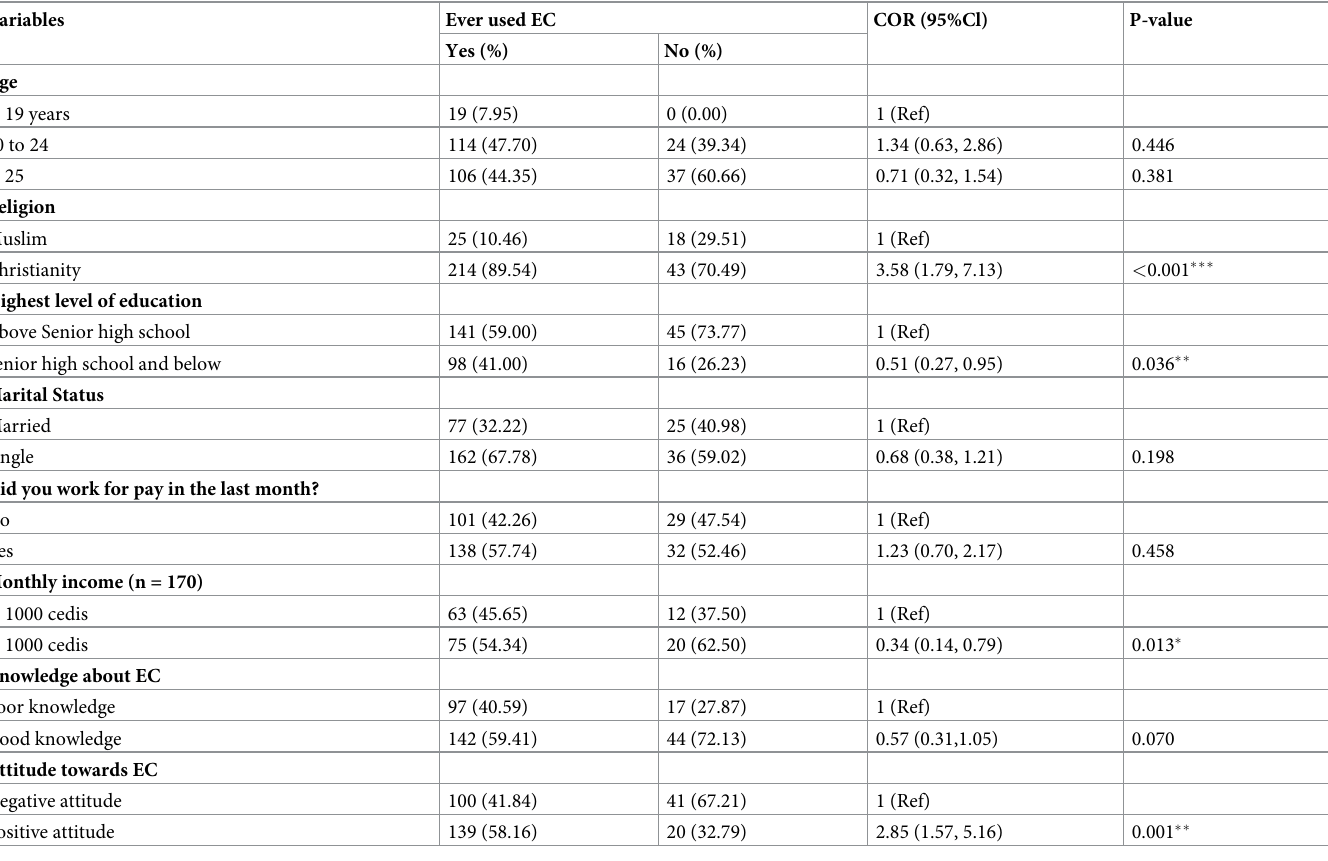
Table 5. Factors influencing emergency contraception usage among the women in the Kwadaso